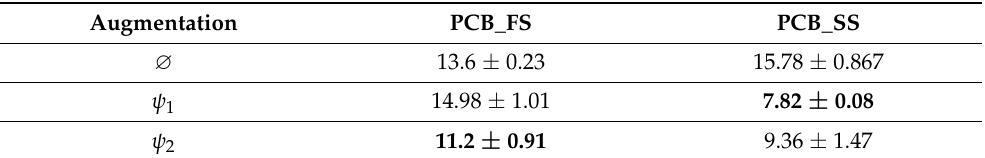
Table 9. Error rates of test data of PCB_FS and PCB_SS models with varying augmentations ( ∅ : no augmentation, and ψ 1 and ψ 2 are selected augmentations, Best result in bold).